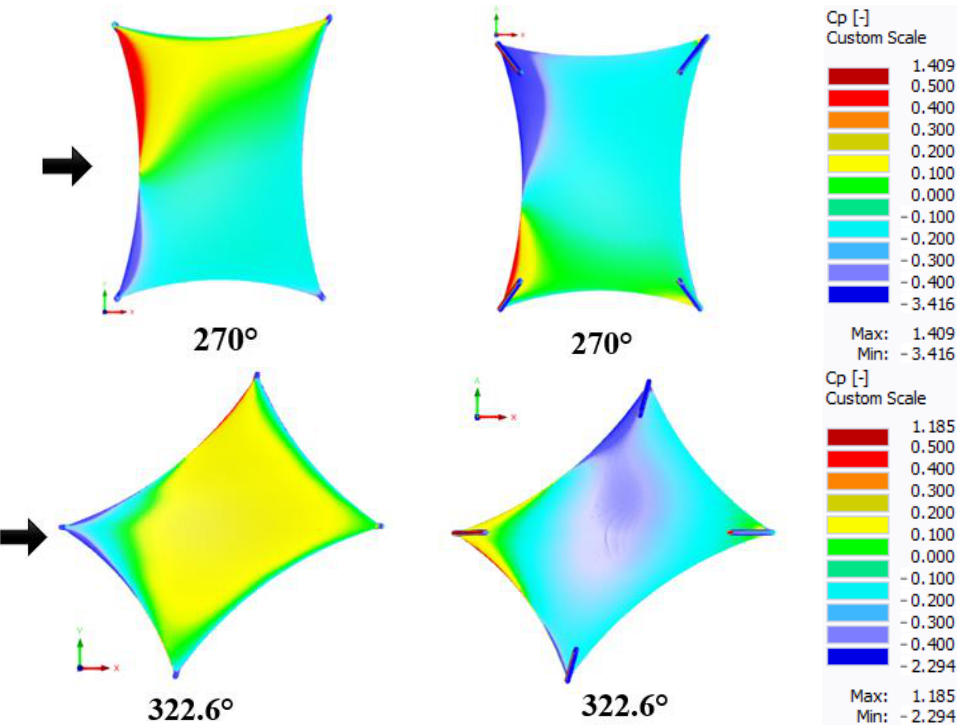
Figure 10. The pressure coefficients C p for the given directions; top surface on the left, the bottom surface on the right.